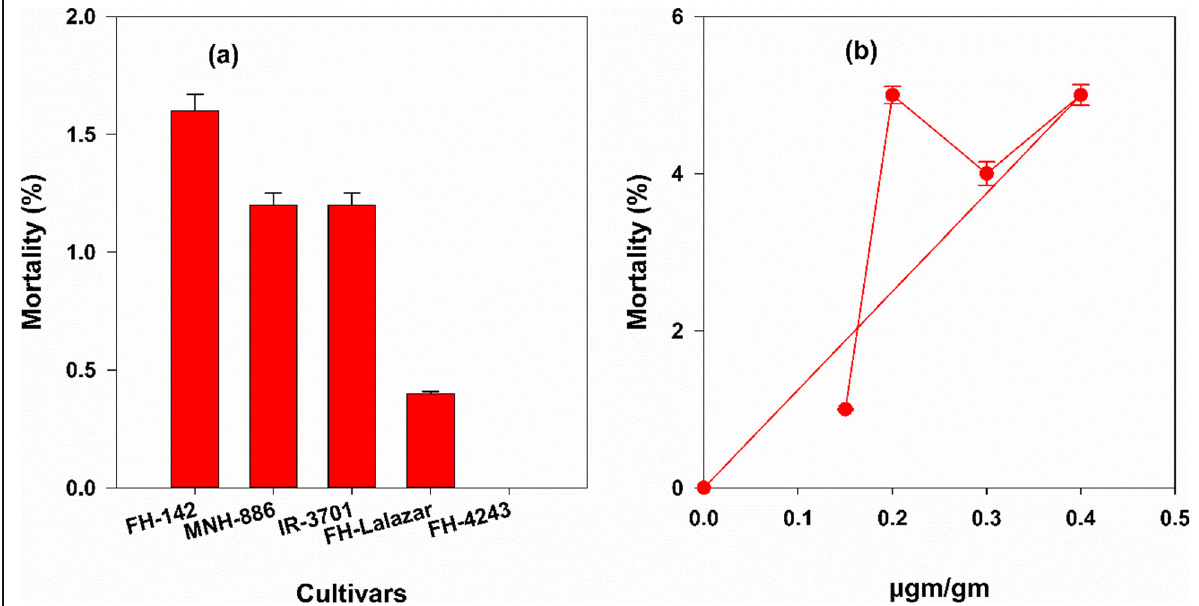
Fig. 4 a Mortality percentage of Pectinophora gossypiella by feeding bolls of different cultivars after 90 days of infestation. b Scatter diagram indicating Cry1Ac concentrations inducing larval mortality of Pectinophora